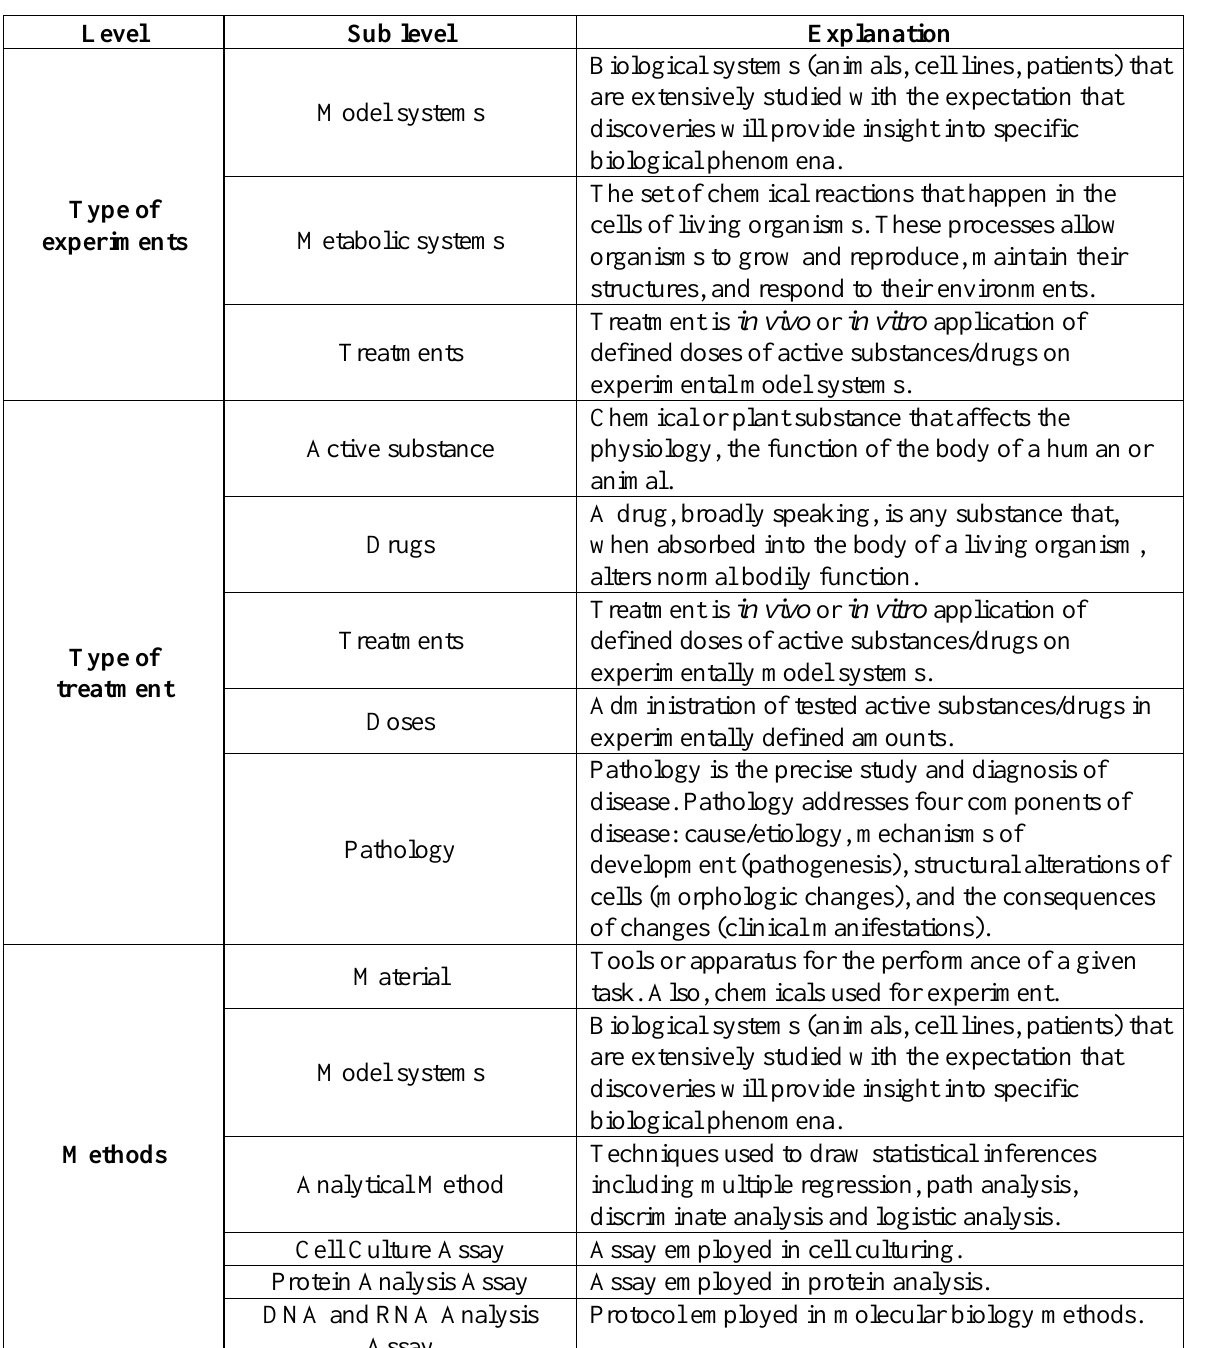
Table 1. Explanations of some experiment